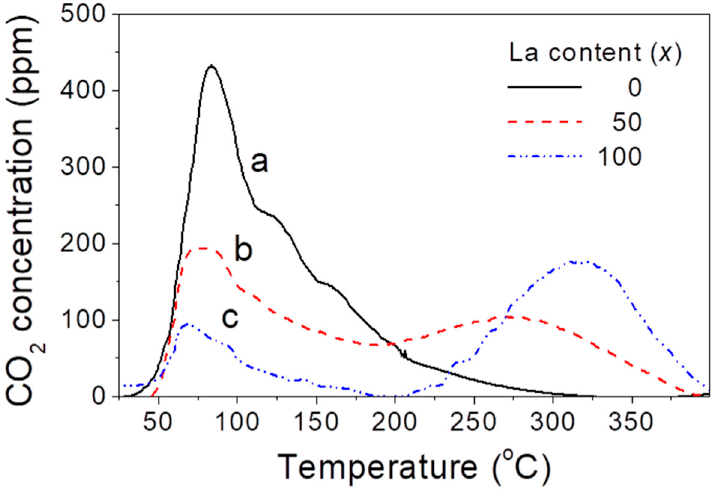
Figure 2. CO 2 -temperature-programmed desorption (TPD) profiles obtained for the pre-reduced CZA-La x catalysts: (a) x = 0; (b) x = 50; (c) x = 100.